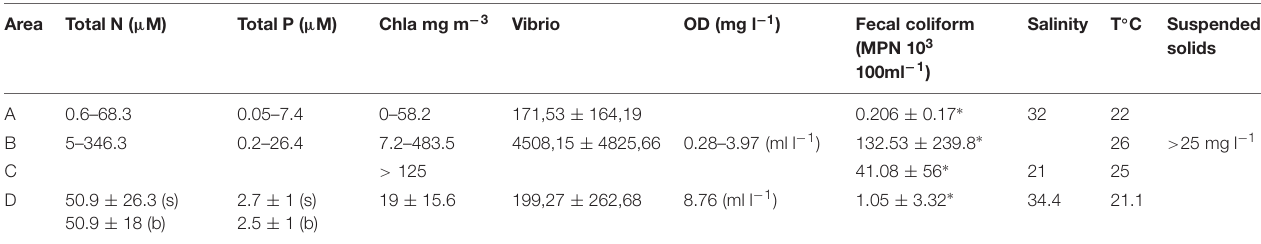
∗ Annual mean calculated from data by INEA. When data was available, differences are shown for surface (s) and bottom water (b), and presented as mean ± SD. Data were retrieved from several sources: JICA (1994), Kjerfve et al. (1997), Paranhos et al. (1998), Paranhos et al. (2001), Marques et al. (2004), Gregoracci et al. (2012), INEA (2013;